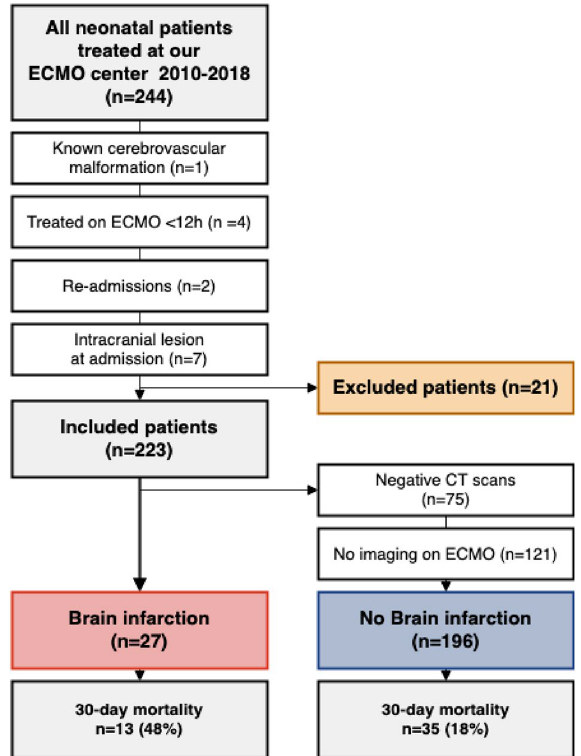
Figure 1. Flow-chart of the patient inclusion process and main results. CT = computed tomography, ECMO = extracorporeal membrane oxygenation, ICH = intracranial hemorrhage, CNS = central nervous